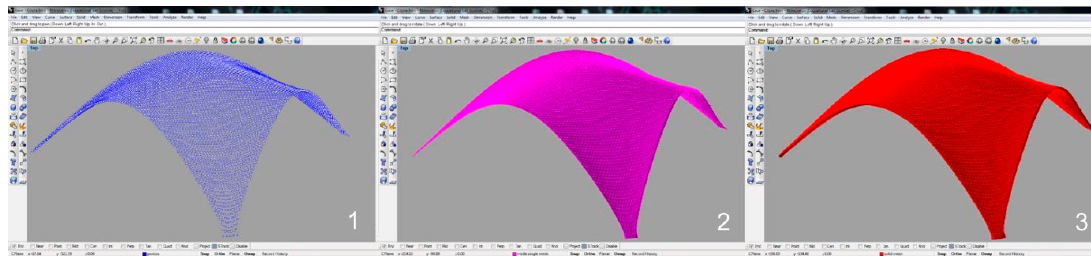
Figure 4. Rhinoceros ® environment: ( 1 ) point cloud; ( 2 ) mid-plan mesh; ( 3 ) solid mesh.